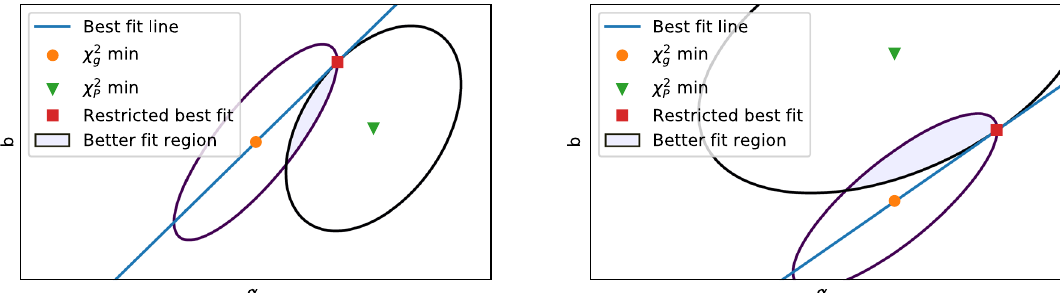
P : the value of α red square is the restricted best-fit α r s corresponding 0 2 , i.e. the point with lowest χ 2 along the best-fit to lowest restricted χ r P P line.Theellipsesarefixed χ 2 and χ 2 g contours.Theshadedareadenotes P for process P ) and χ 2 P ) . The two < χ 2 (α r P the region in which both χ 2 g < χ 2 g (α r P P 0 0 plots correspond to two possible scenarios (see